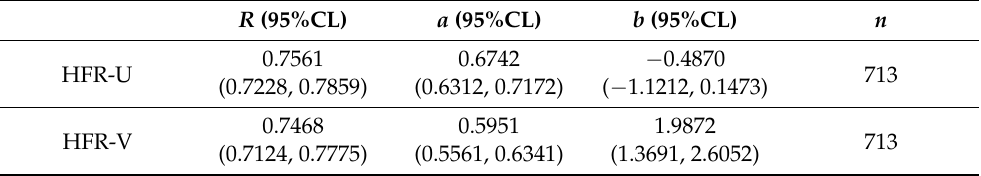
Table 2. Comparison metrics (scalar correlation coefficient R , slope and intercept of the linear best fit model) for the HFR-drifter data, separate for the U (V) velocity components, along with the 95% confidence levels (CL) and the number of samples ( n ) used in the